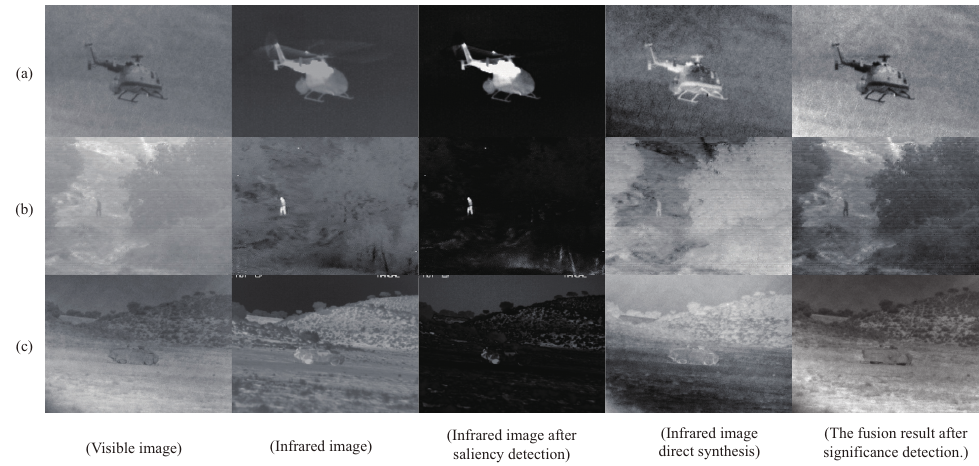
Figure 6. Comparison of images regarding significance detection. Each row is an image from the TNO dataset ( a – c ). From left to right, each row is as follows: Visible image. Infrared image. Infrared image after saliency detection. Infrared image direct synthesis. The fusion result after significance